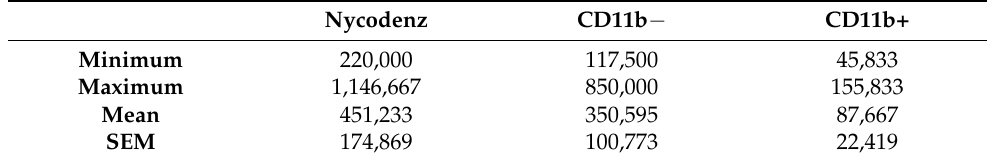
Figure 1. ( A ) After Nycodenz separation, high-lipid-content cells float (white ring) between the Nycodenz solution and the GBSS + NaCl solution (yellow arrow). ( B ) Cell viability assessed with fixable EF 780 viability dye back gated in side scatter (SSC) and forward scatter (FSC)-contour plot with outliers as dots. Green: viable cells; red: dead cells. Proportion expressed as a mean ± SD, n = 3. ( C , D ) Quantitative polymerase chain reaction assessing DCN (coding for Decorin) ( C ) and CLEC4F (coding for Clefc4f) ( D ) gene expression in cell populations after the two major steps of HSC isolation (Nycodenz and MACS sorting). Values obtained were expressed as fold-increase (FI) where the value obtained by non-parenchymal cell (NPC) population was set as 1. Decorin has been described to be specific to HSCs whereas CLEC4F is expressed by Kupffer cells. * p ≤ 0.05, ** p ≤ 0.01, *** p ≤ 0.00, if not specified, non-significant. n = 2. Table 1. Cell yield per mouse after HSC Nycodenz separation alone or after additional negative CD11b selection. Nycodenz: yield without CD11b negative selection. CD11b − : HSC enriched fraction (flow through). CD11b+: macrophages (selected cells). SEM: standard error of the mean. Yield variations reflected fluctuations in liver digestion and learning curve of the isolation procedure. n = 3 to